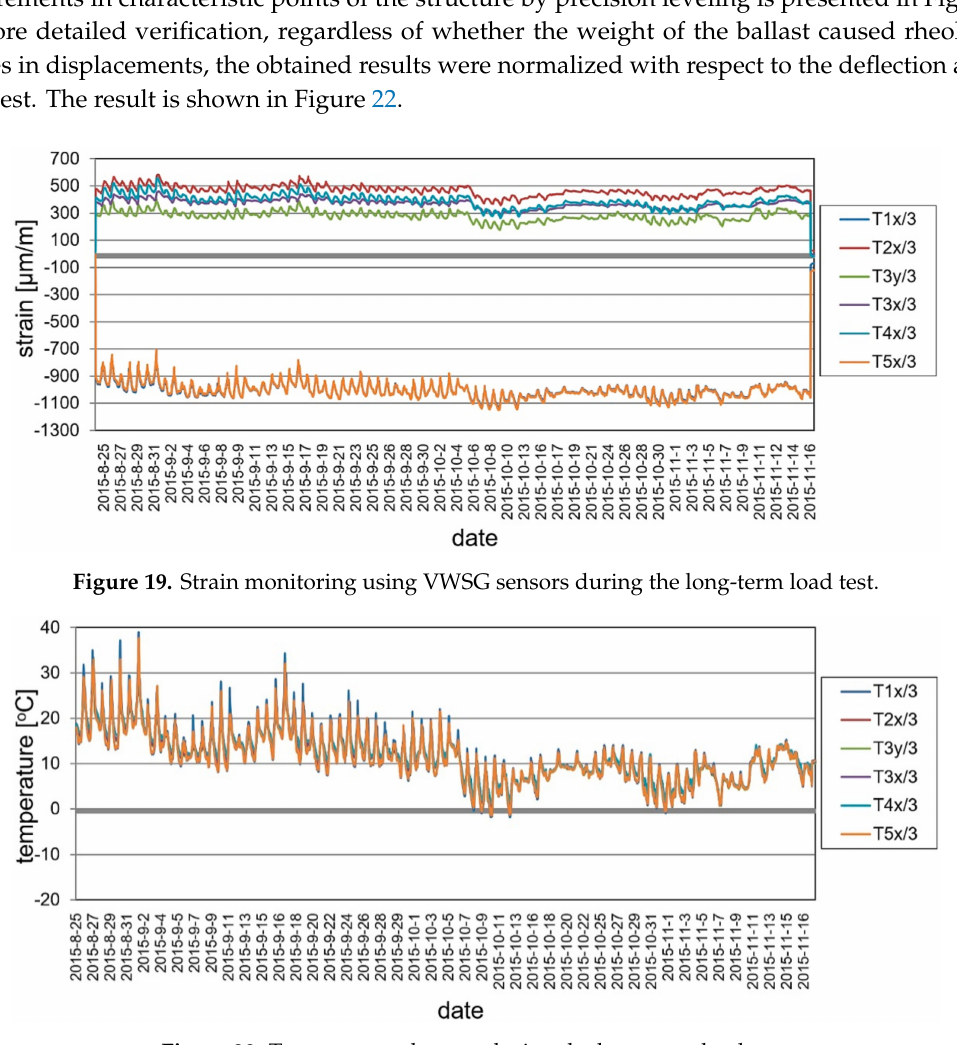
Figure 20. Temperature changes during the long-term load